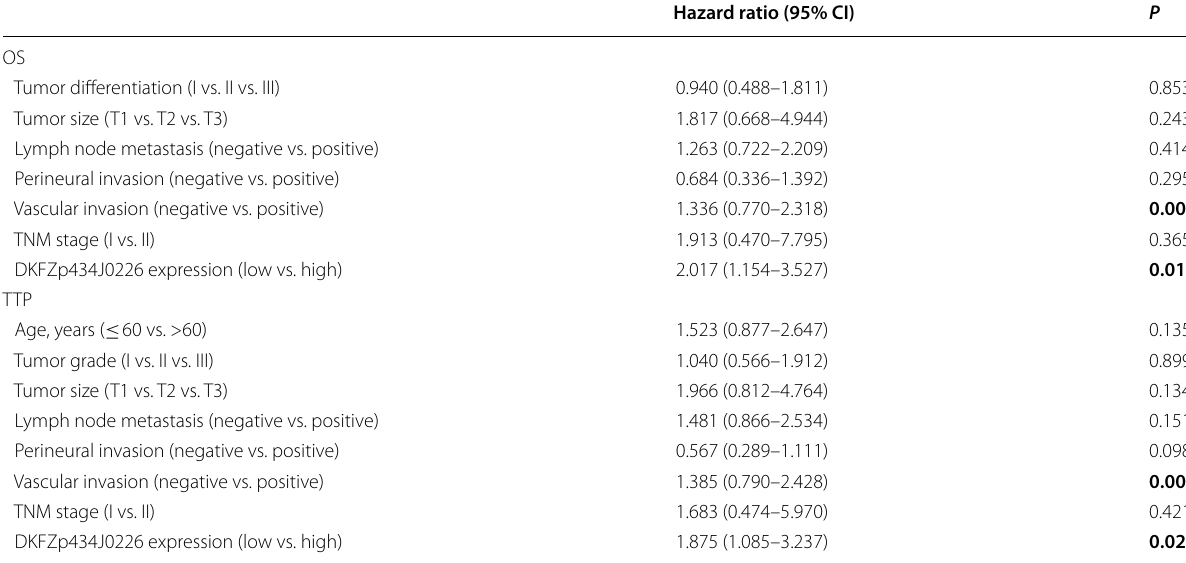
Table 1 Multivariate analyses of factors associated with OS and TTP